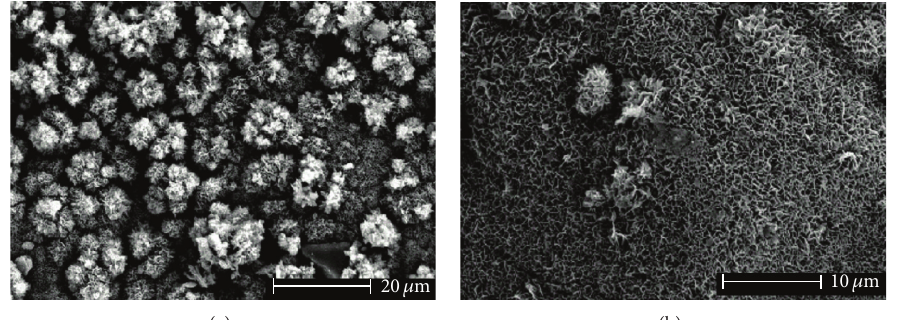
Figure 8: Micrographs of specimen exposed at Cubat˜ao for one month, showing “cotton ball” structures, (a) and nest formations, interconnecting the cotton balls (b).